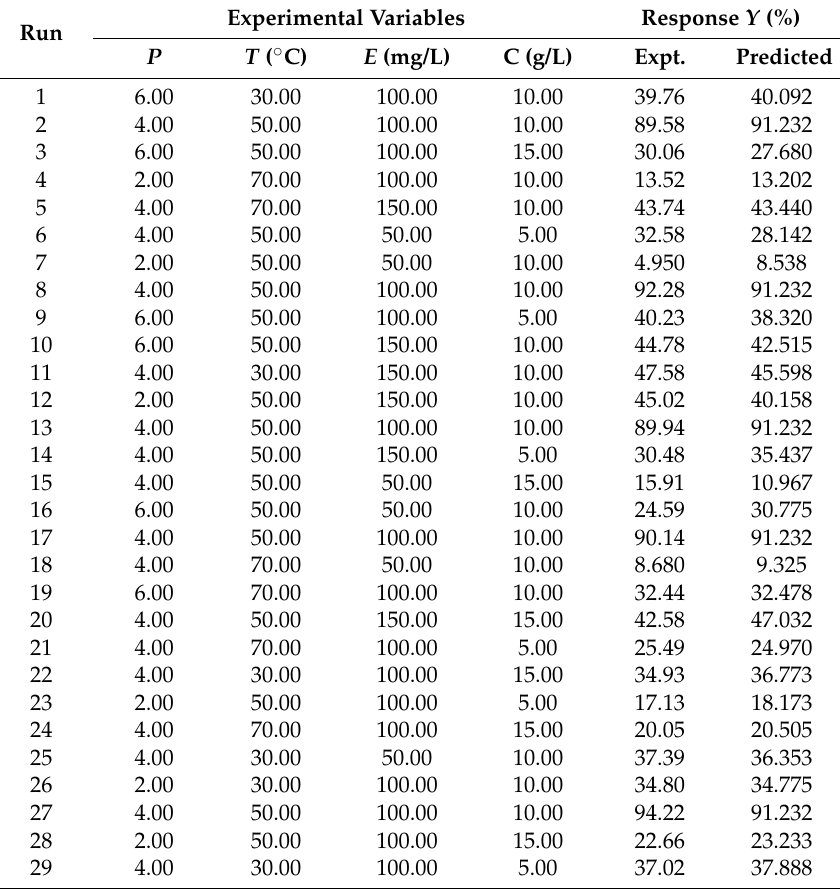
Table 2. Experimental Box–Behnken design matrix and its response and predicted value. Experimental Variables Response Y Run